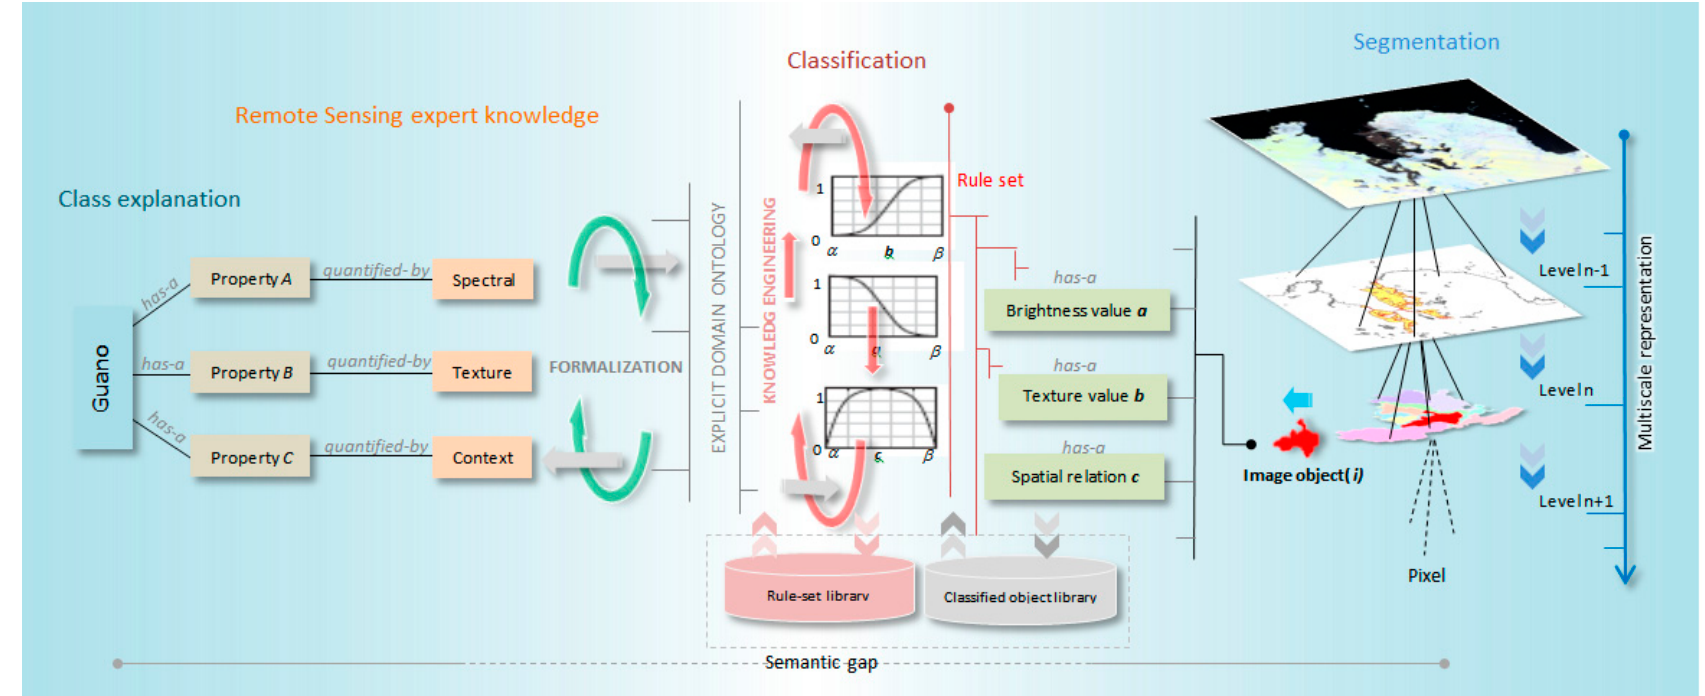
Figure 2. Object-based penguin guano detection from VHSR images.